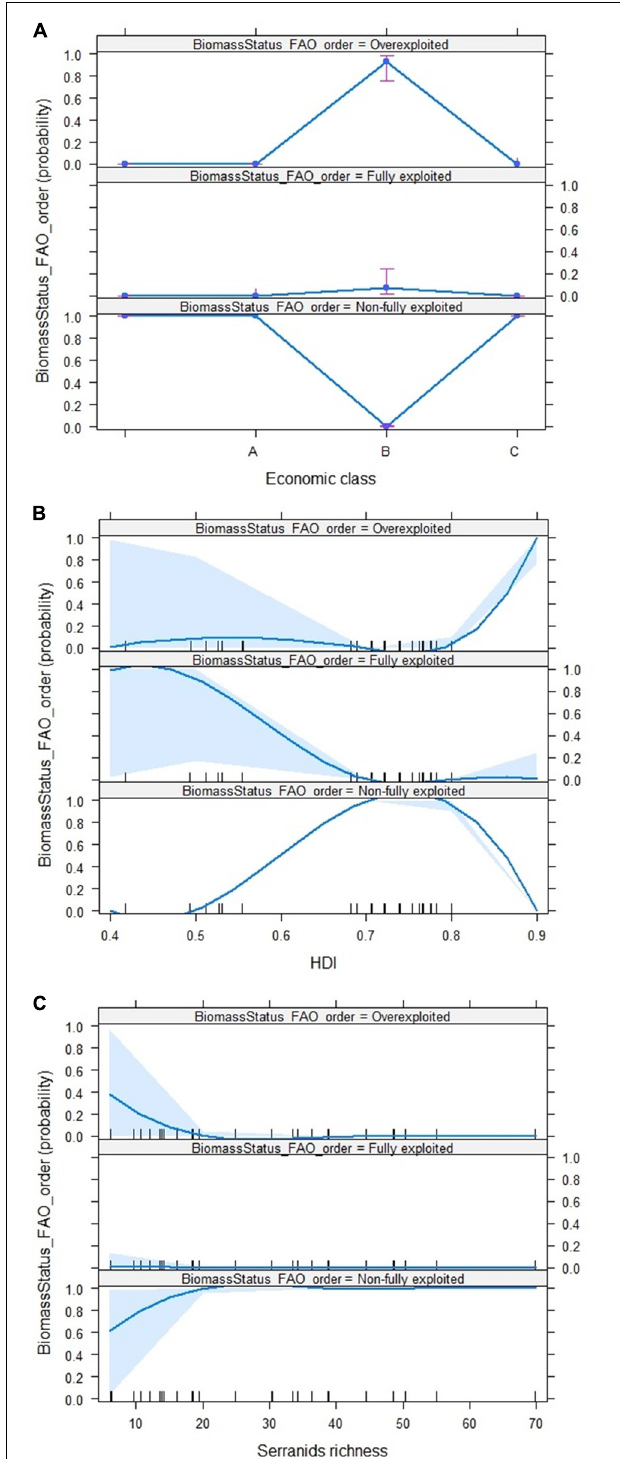
FIGURE 11 | Simulation models of the effect of each significant explanatory variable on the biomass stock category (response), as detected by the multinomial model. (A) Economic classes (A – Least developed, B – Other developing and, C – Developed); (B) Human Development Index (HDI), and (C) serranid richness.